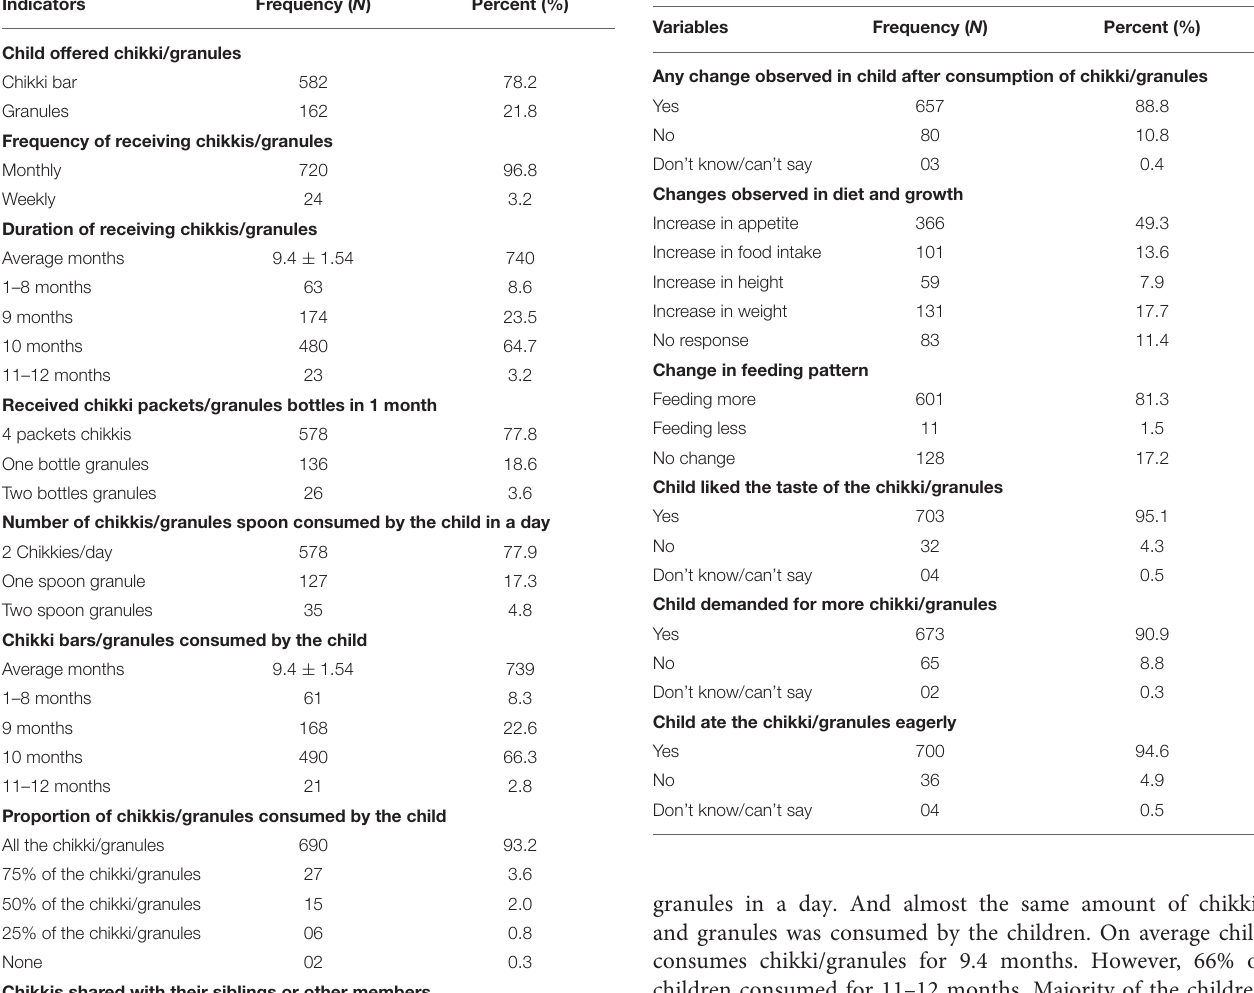
TABLE 4 | Mothers perception about the changes in child’s diet, and growth after consumption of chikkis/granules ( N = 740).